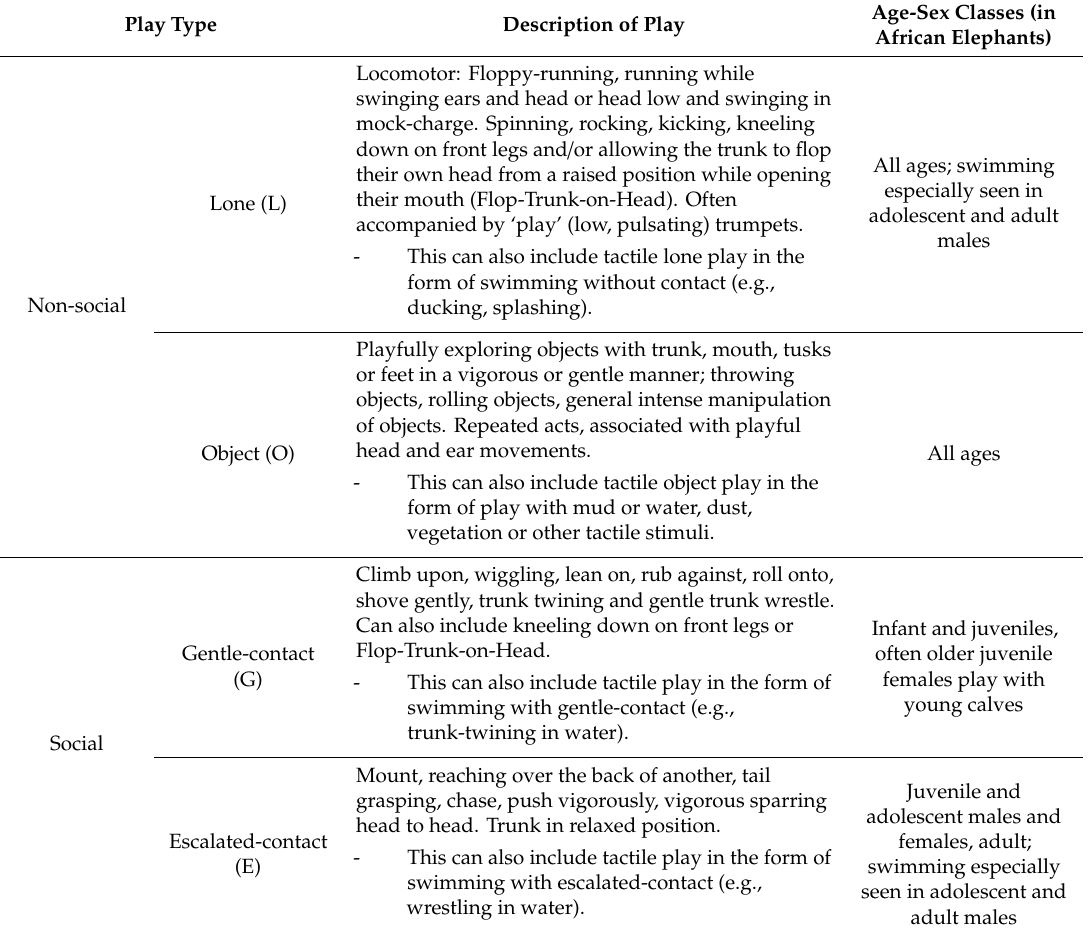
Table 1. Play types in elephants modified from [10,55]. Note that the analysis here was based on the gross categorisations of play types, rather than on the details of descriptions which are provided as background